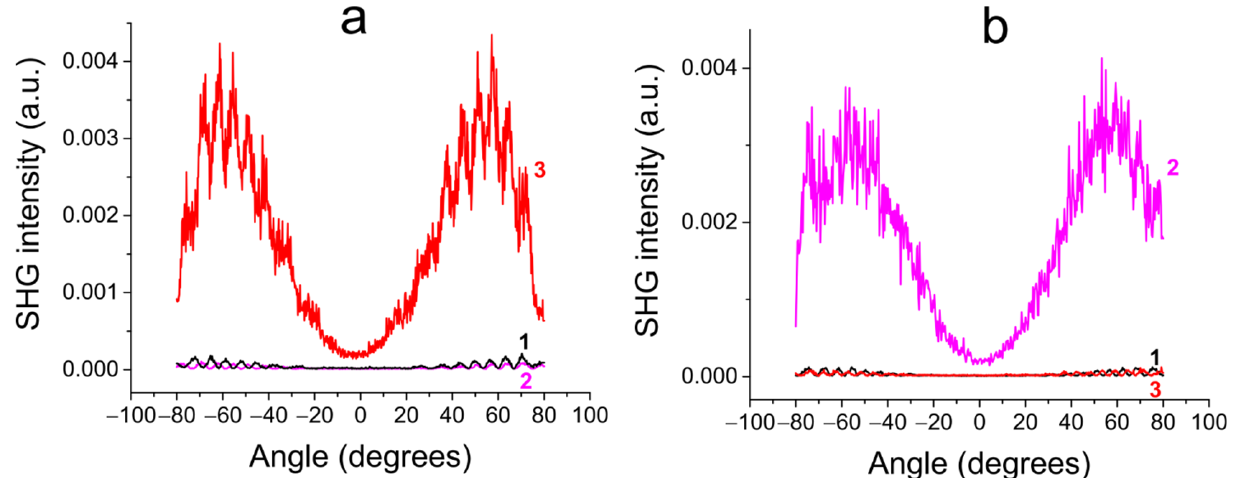
Figure 2. Maker-fringes SHG patterns of Menzel ( a ) and BF16 ( b ) glass slides: 1—virgin slides, 2—e-beam poling at electron energy 20 keV and ICSD 1.8 µQ/cm 2 , 3—thermal poling at 300 °C in air atmosphere under 800 V DC.